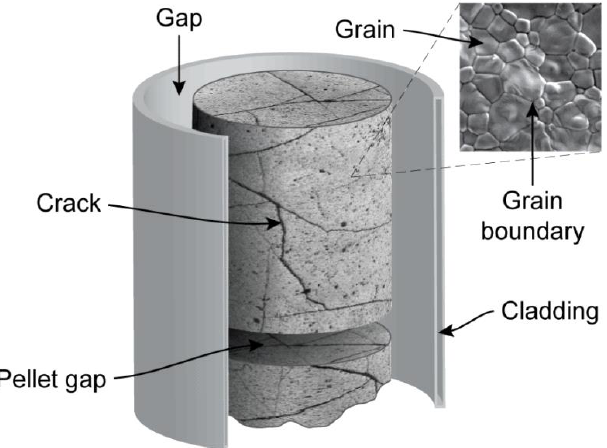
Figure 2. The macro- and microstructure of a fuel pellet after its irradiation showing the main fea- features, such as cracks, the surrounding cladding, and the pellet–cladding gap, in addition to the tures, such as cracks, the surrounding cladding, and the pellet – cladding gap, in addition to the grain grain boundaries (shown in the inset, at a larger scale). The sizes of the pellet–cladding gap and boundaries (shown in the inset, at a larger scale). The sizes of the pellet – cladding gap and pellet – pellet–pellet gap are exaggerated for clarity pellet gap are exaggerated for clarity [5].